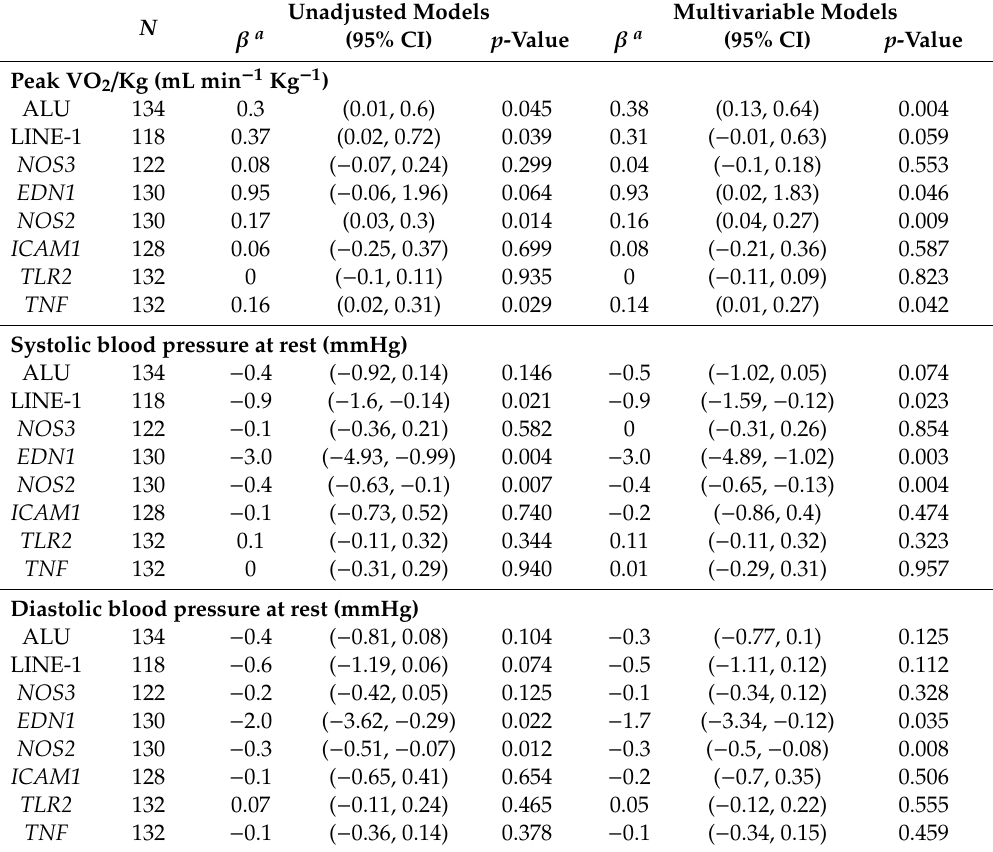
Table 4. Unadjusted and multivariable regression models (Adjusted for gender, age, BMI and smoking status) estimating the e ff ects of a 1% increase in DNA methylation on cardiovascular outcomes (Peak VO 2 / Kg, PAS at rest and PAD at